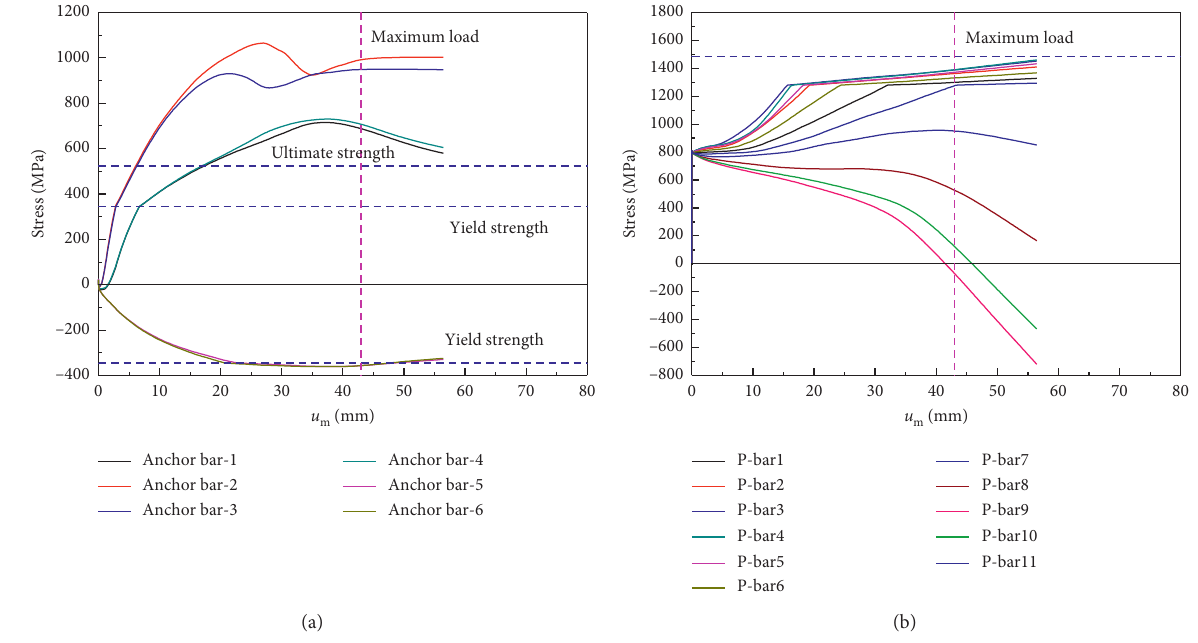
Figure 23: Stress-displacement curves of CT-9. (a) Anchor bar. (b) Prestressed bar.